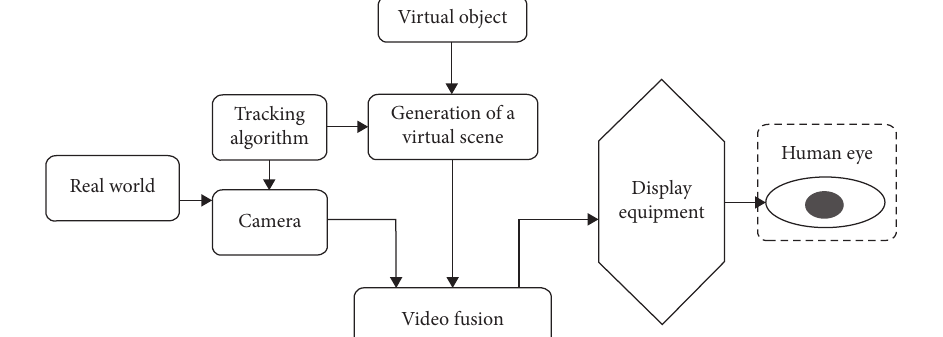
Figure 1: Garment design